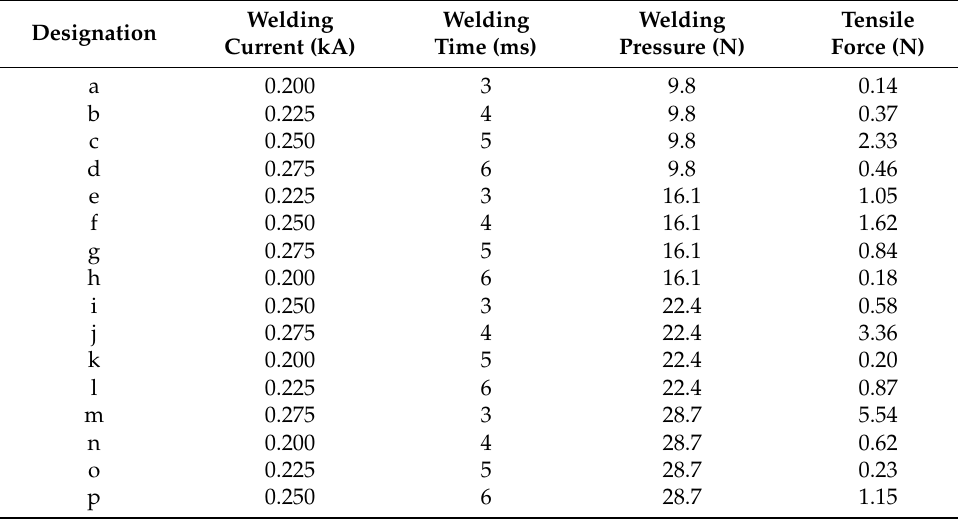
Table 1. Orthogonal experiment parameters and tensile force